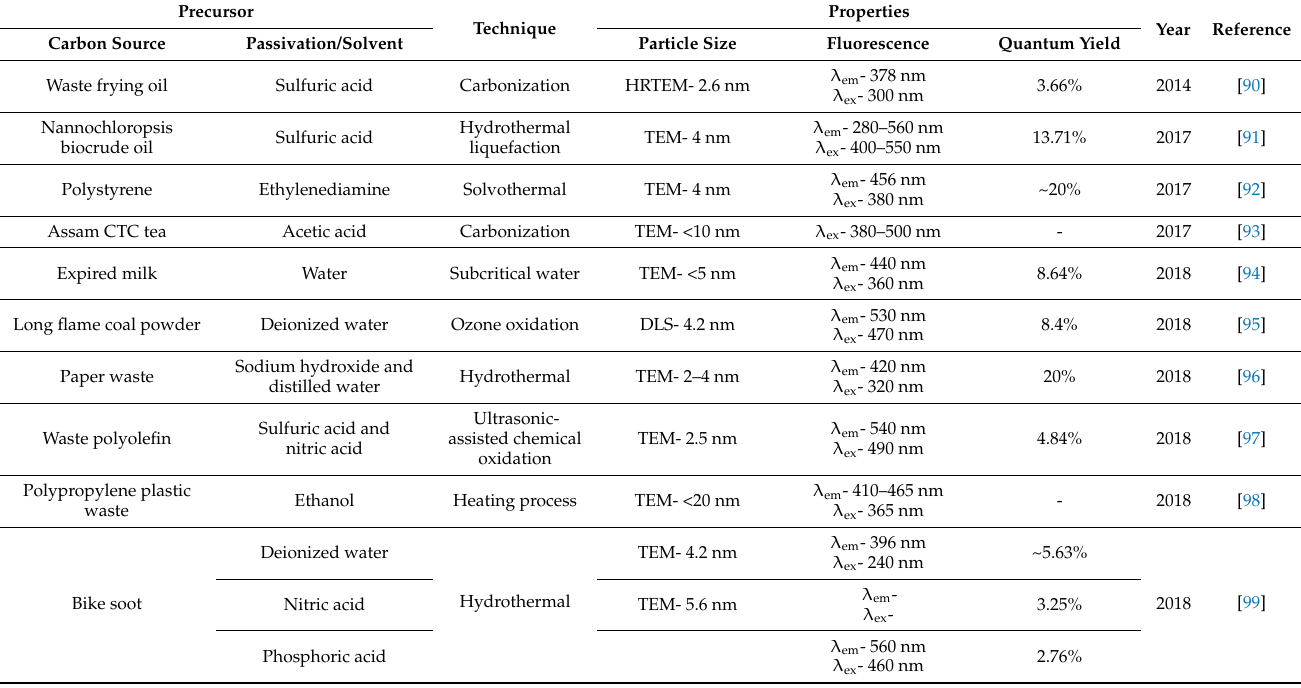
Table 7. Summary of the synthesis of CDs from waste